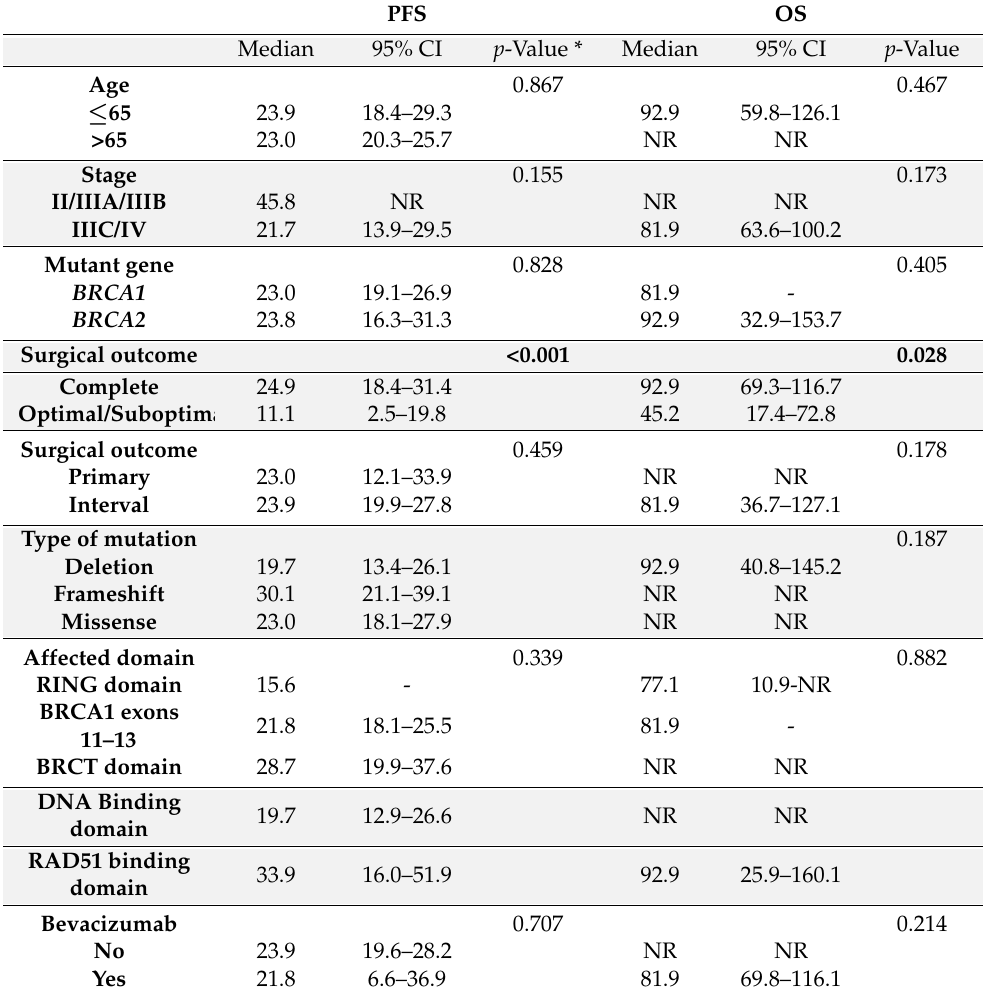
Table 2. Median PFS, OS with 95% CI, Univariate